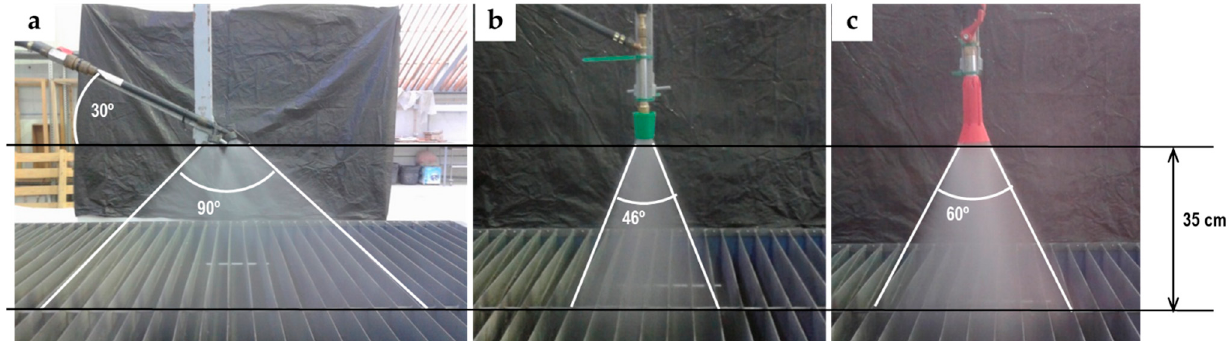
Figure 5. Testing the hand-held sprayers on a horizontal test bench (ISO 5682-1-compliant) to determine the actual spray angle: the flat-fan spray lance ( a ), rotating-handle spray lance ( b ) and trigger spray gun ( c ).